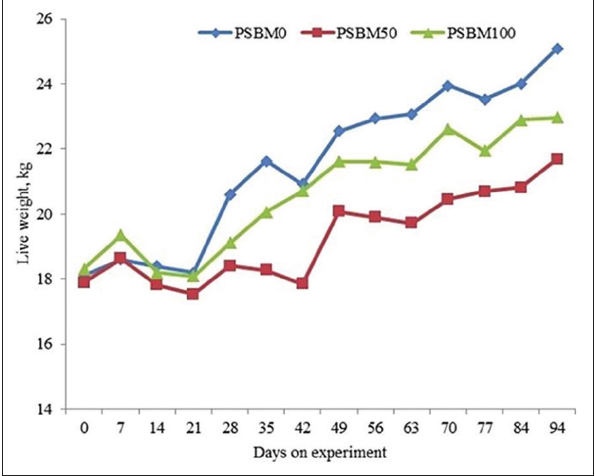
Figure-1: Body weight of Kacang goats receiving formaldehyde-protected soybean meal 0% (PSBM0), 50% (PSBM50), and 100%